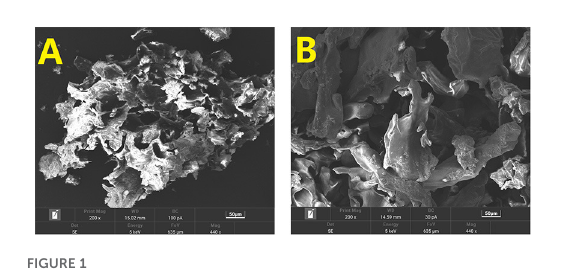
FIGURE1 SEM analyses of SDF (A) and IDF (B) at × 200